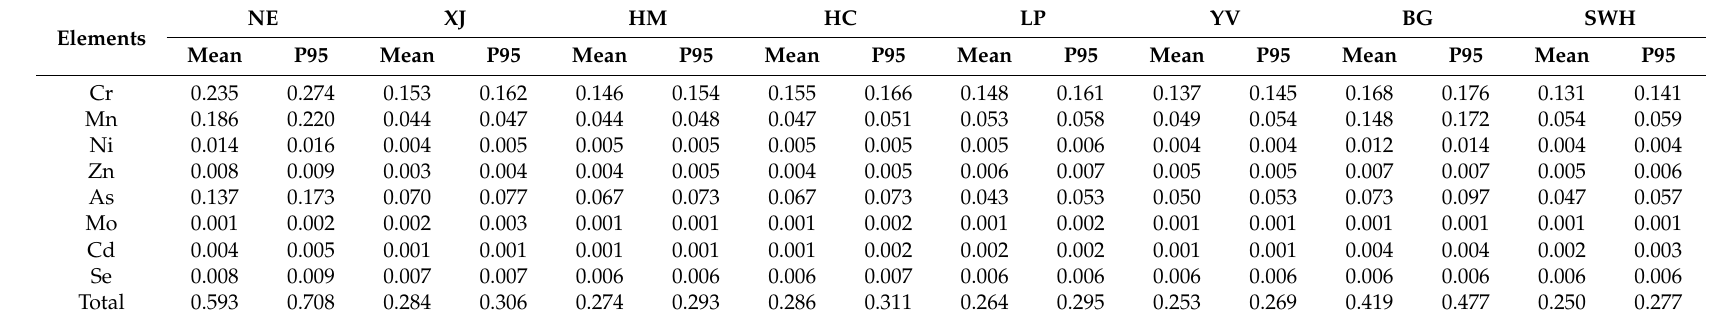
Table 4. Target hazard quotient (THQ) of trace elements from wines of different